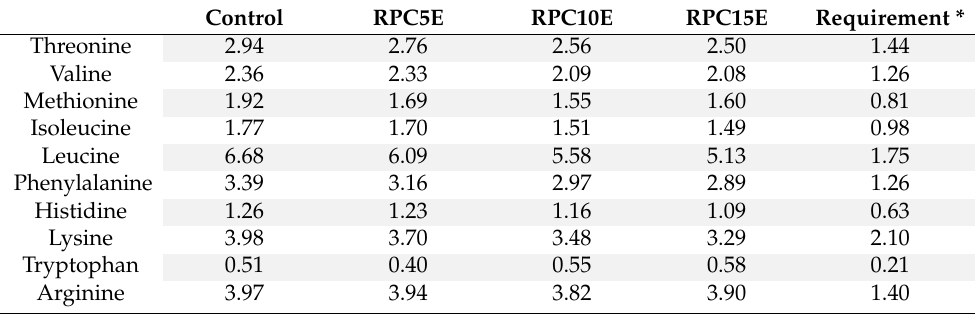
Table 3. Essential amino acid composition of experimental